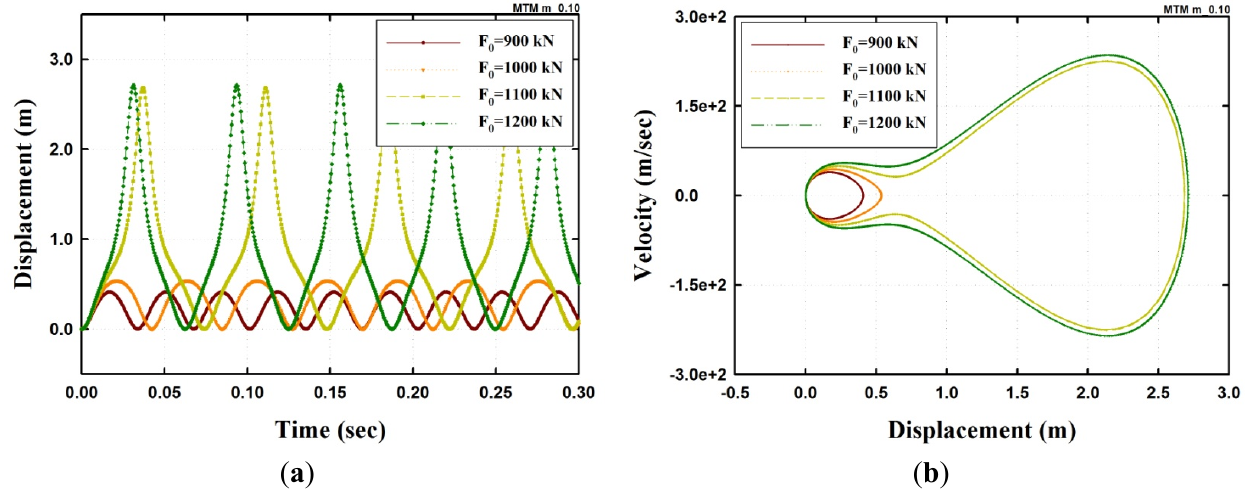
Figure 3. Dynamic analysis results of an undamped SFN model under a step